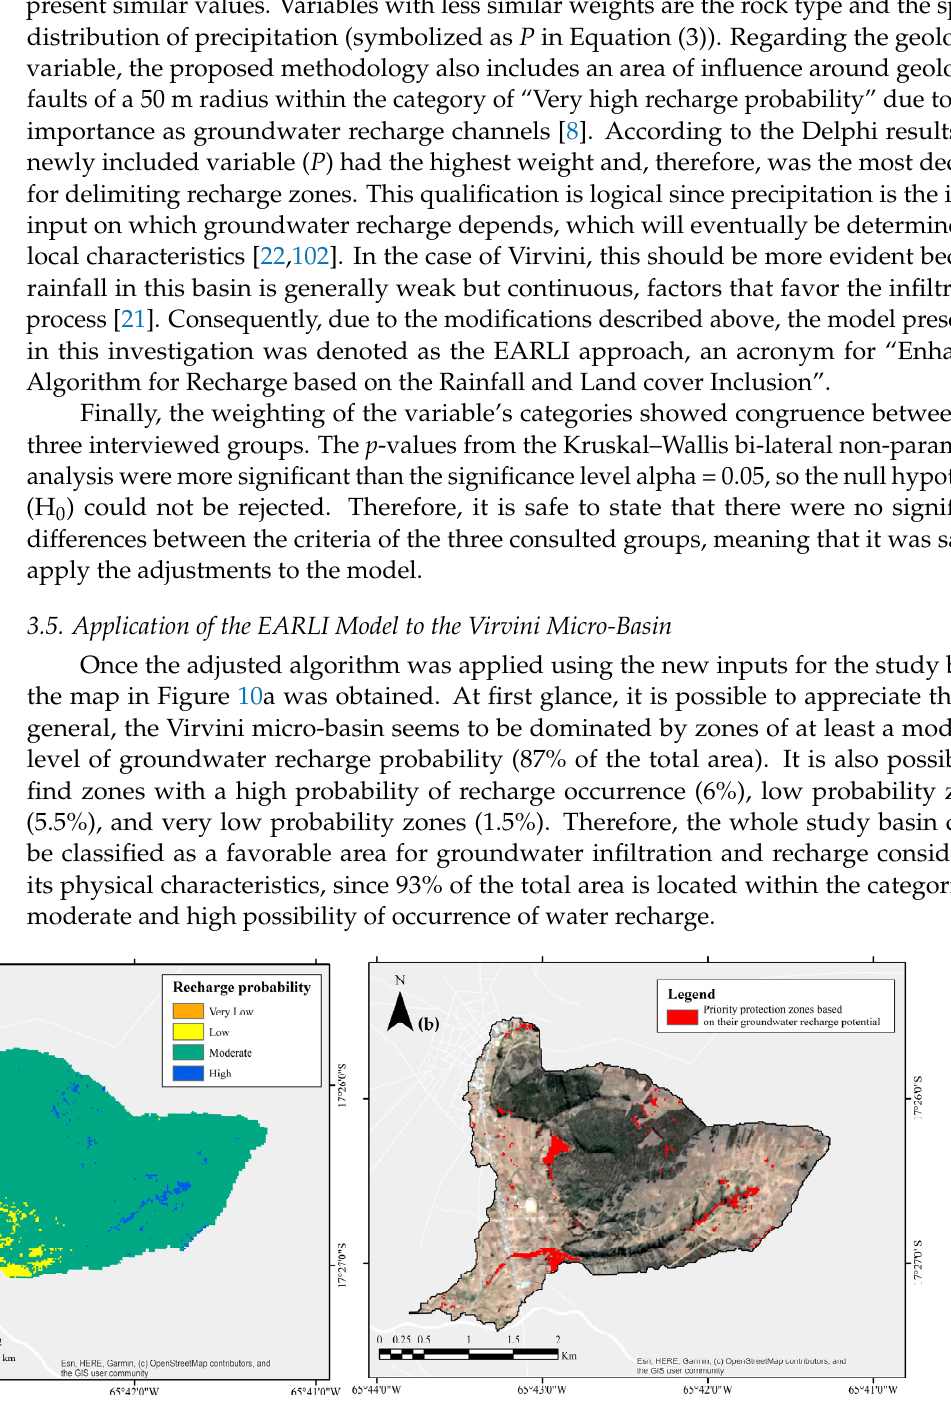
Figure 10. ( a ) Map of groundwater recharge probability for the Virvini sub-basin, according to the EARLI equation (Equation (3)); and ( b ) proposed priority protection zones based on their groundwater recharge potential.